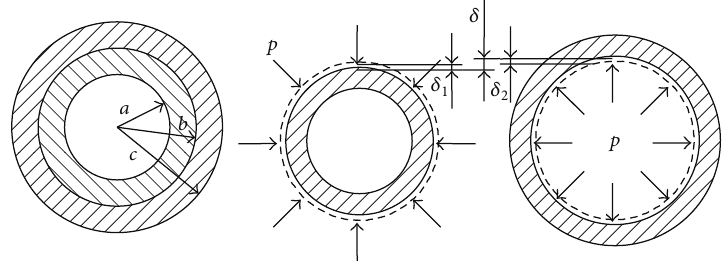
Figure 1: Assembly diagram of shaft and sleeve.